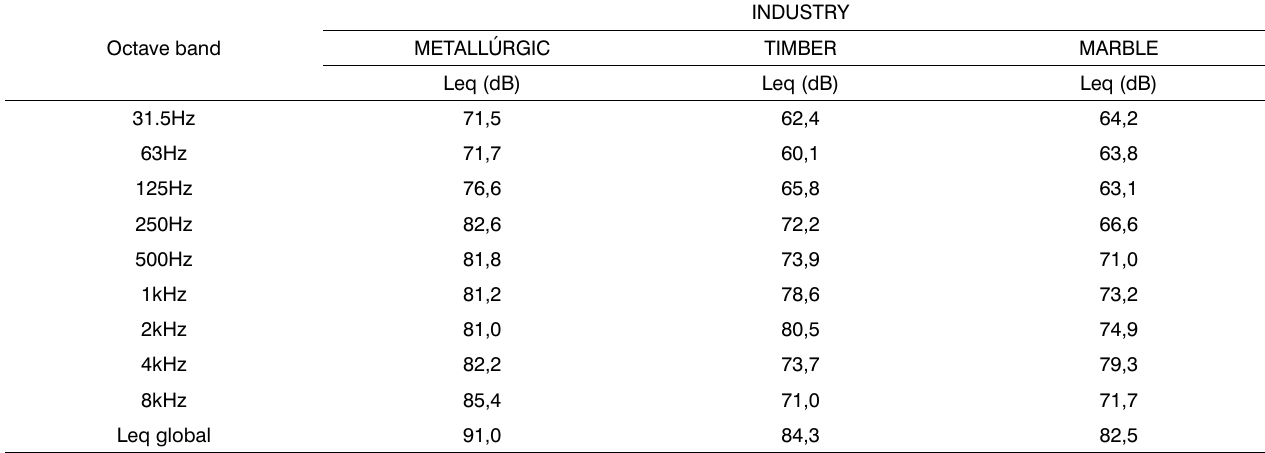
Legend: RE right ear; LE left ear; BE Both ears Table 3. Environmental noise spectrum broken down by industry, Distrito Federal,